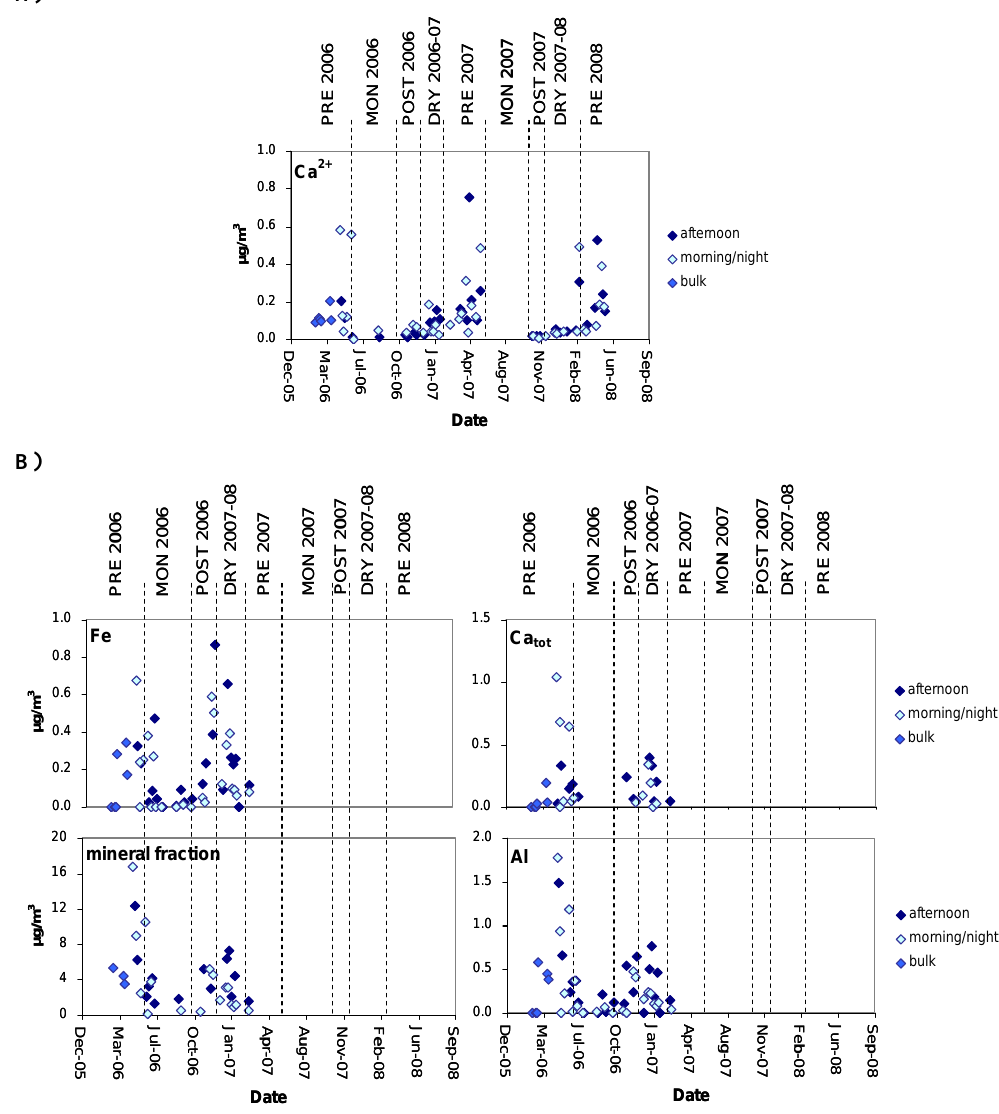
Fig. 3. Concentrations of (a) water-soluble calcium and of (b) mineral elements in PM 10 samples. Ca tot stands for total calcium measured by AAS. The mineral fraction concentrations are calculated on the basis of the equation reported in Sect.